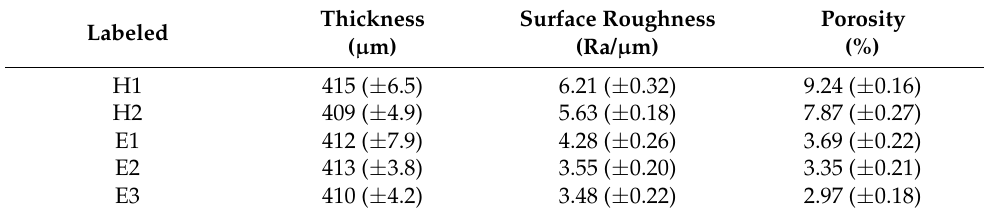
Table 4. Coating